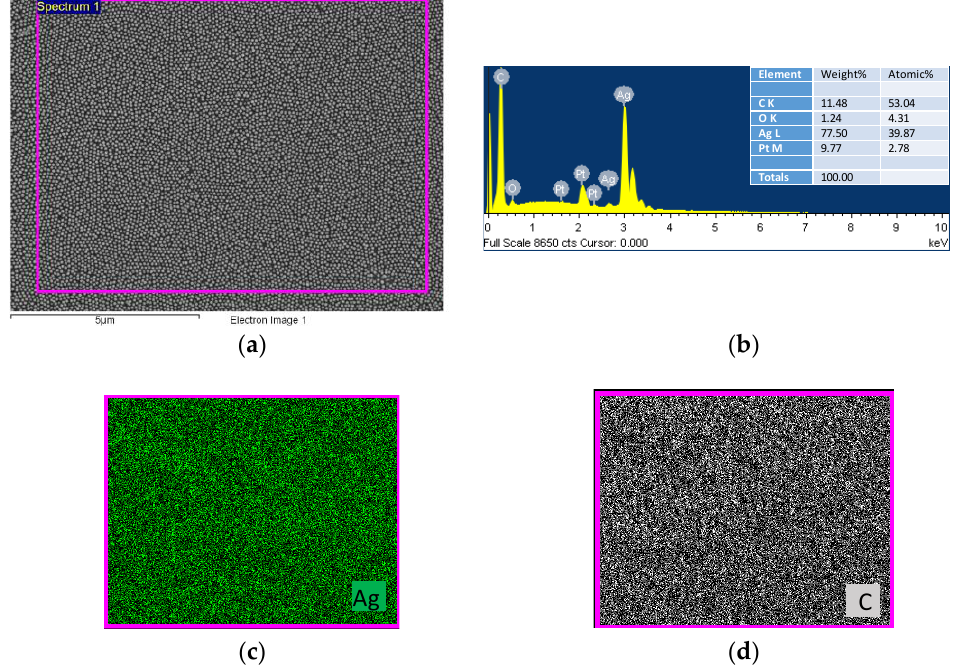
Figure 5 . ( a ) Shows the SEM image of the SERS active substrate used for EDS analysis ( b ) Shows the EDS spectrum, it shows that the SERS active substrate consisted of 77.5 % Ag and 11.48% C. ( c ) shows the EDS mapping of Ag of the SERS active substrate. ( d ) Shows the EDS mapping of C of the SERS active substrate.